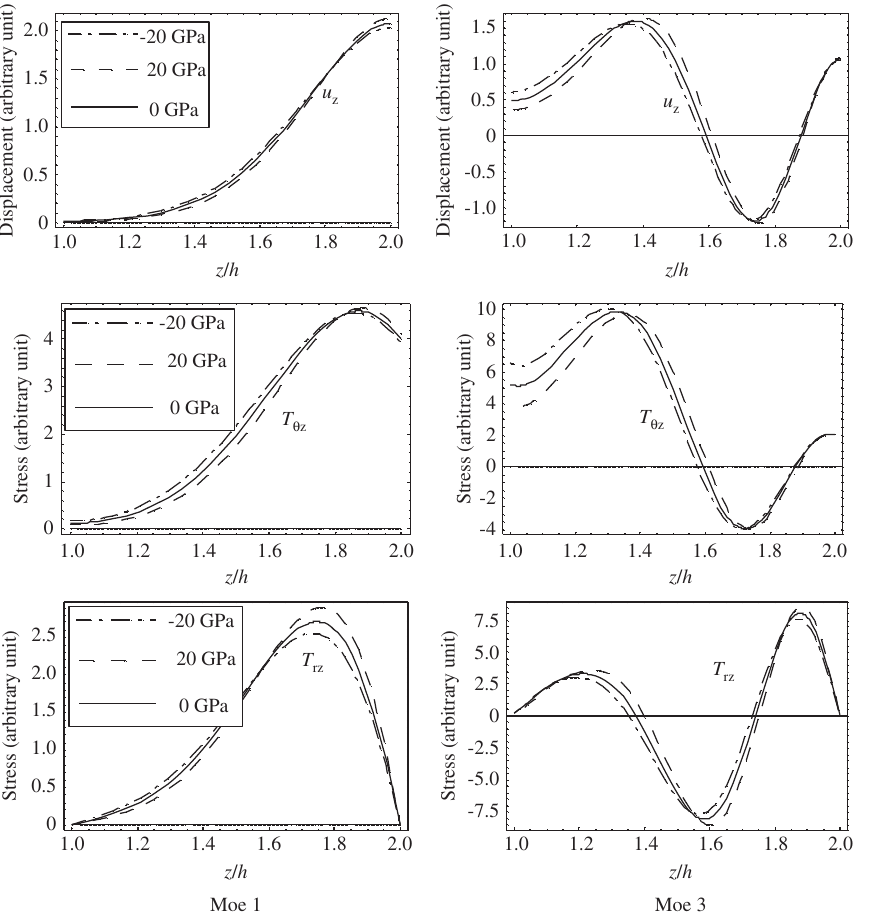
Figure 11 Displacement and stress distributions of circumferential SH wave for the linearly graded cylindrical plate with η = 2 under differ- ent radial initial stress at kh = 5.